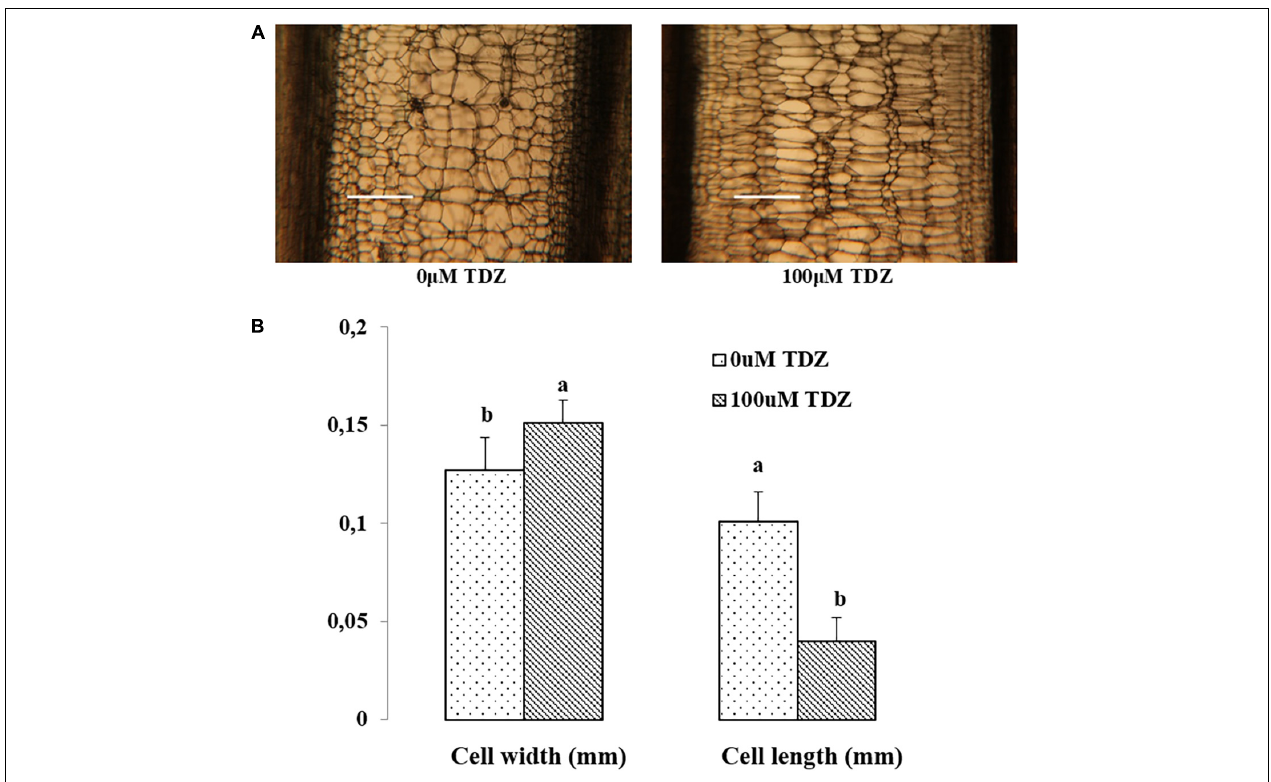
FIGURE 5 | Representative hand-cut longitudinal sections (A) and pith cell width (mm) and length (mm) (B) of third internodes after 15 days of TDZ treatment. Scale bar = 0.25 mm. The data (means ± SE, n = 16) followed by different letters are significantly different at P ≤ 0.05.